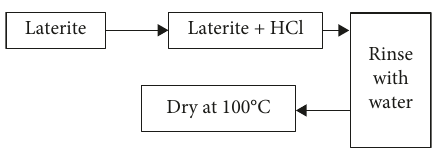
Scheme 2: Thermal denaturation of laterite